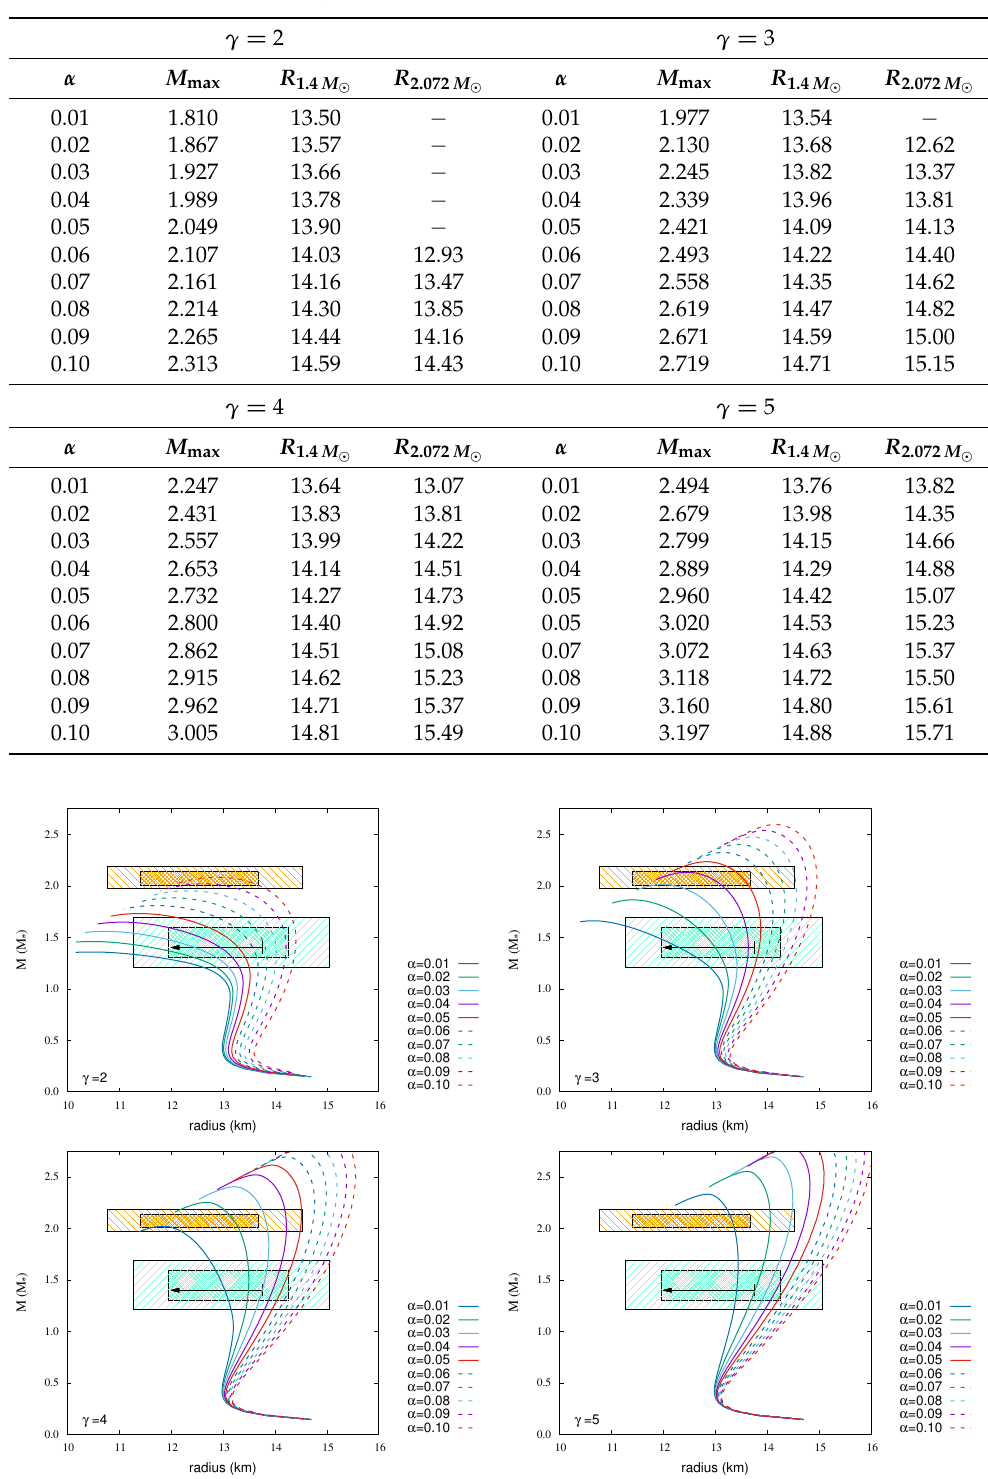
Figure 5. MR relations of GM3 EoS with magnetic fields. The strength of surface magnetic field strength B s is 10 12 G, and the central magnetic field strength B 0 is 2.5 × 10 18 G. The arrow and colored hatched areas are the same as in Figure